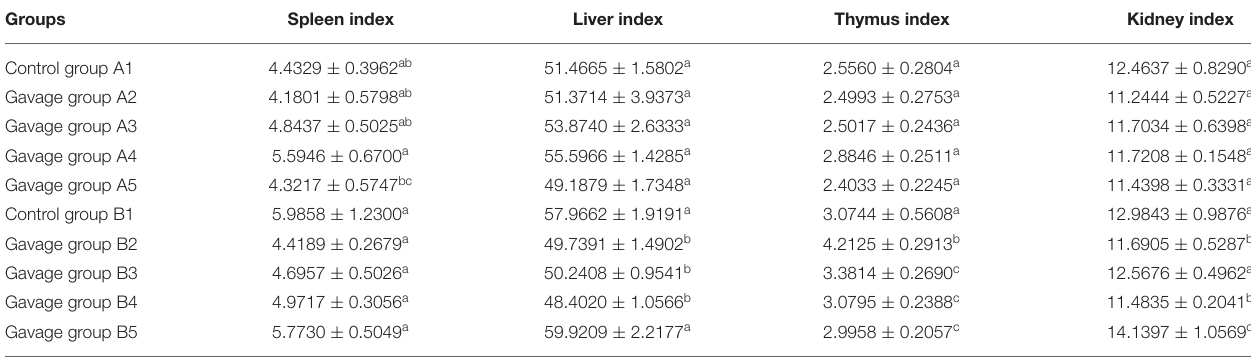
TABLE 1 | Effects of Rhodotorula mociliginosa on mouses organs (15 days and 30 days data). Groups